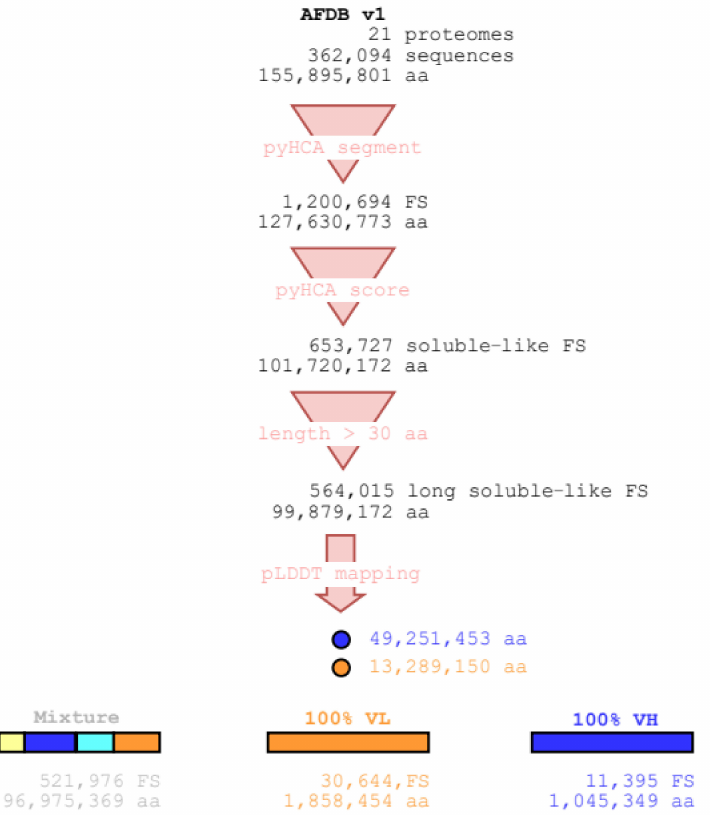
Figure 1. The technical flow for definition of the long soluble-like full-VH and full-VL foldable segments from AFDB v1 by using the pyHCA tool. The number of foldable segments (FS) and the number of residues (aa) are indicated at each step of the flow. The dataset further analyzed in this study consists of the full-VL and full-VH segments. For quantitative details about each of the 21 proteomes, see Supplementary Table